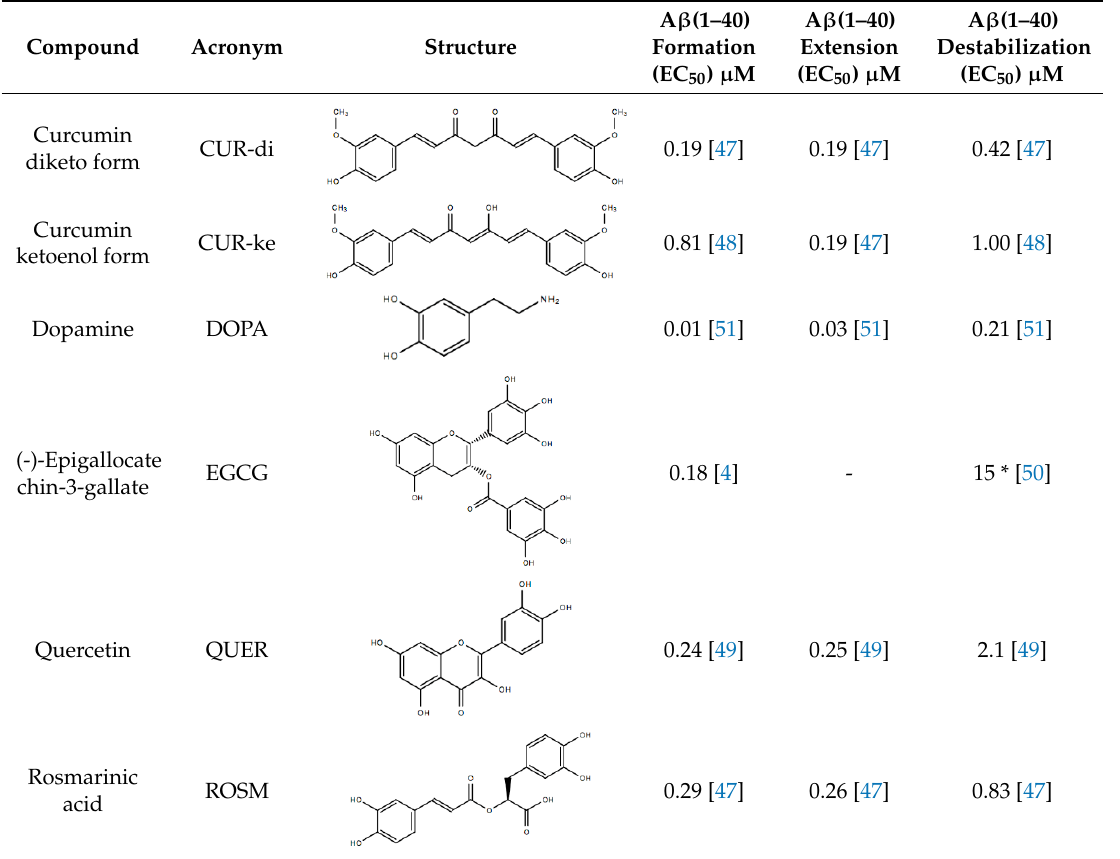
Table 1. The effective concentrations (EC 50 ) of the ligands studied for the formation, extension, and destabilization of fA β (1–40).